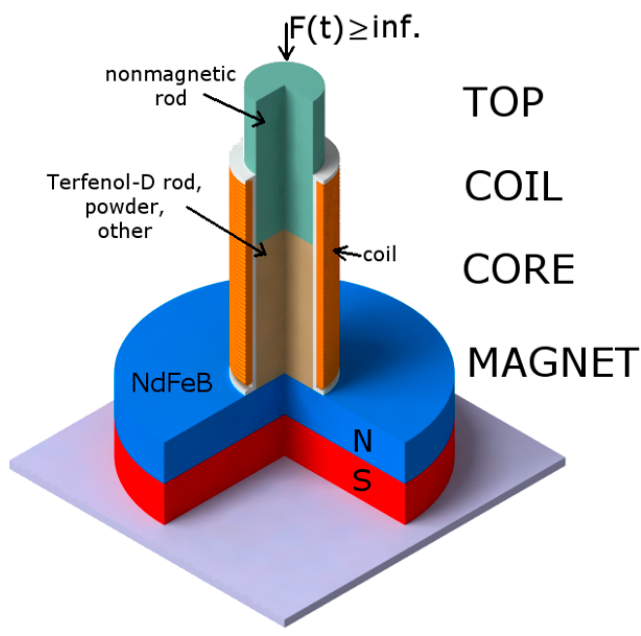
Figure 1. TCCM harvester scheme.